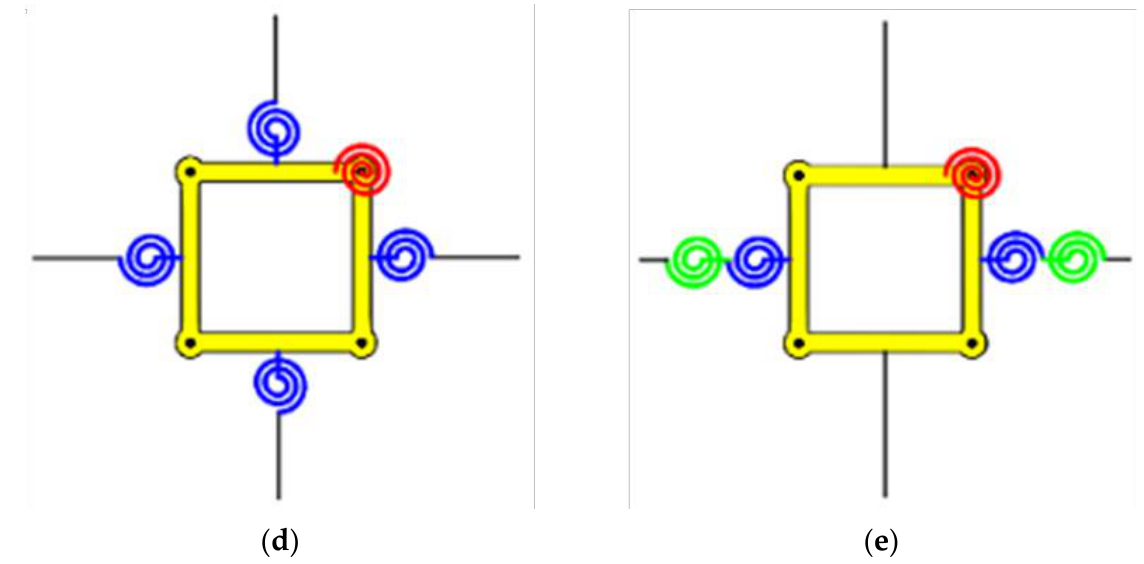
Figure 7. The most common zero-length ( a ) rotational spring model and ( b – e ) multi-spring models, based on literature [49].